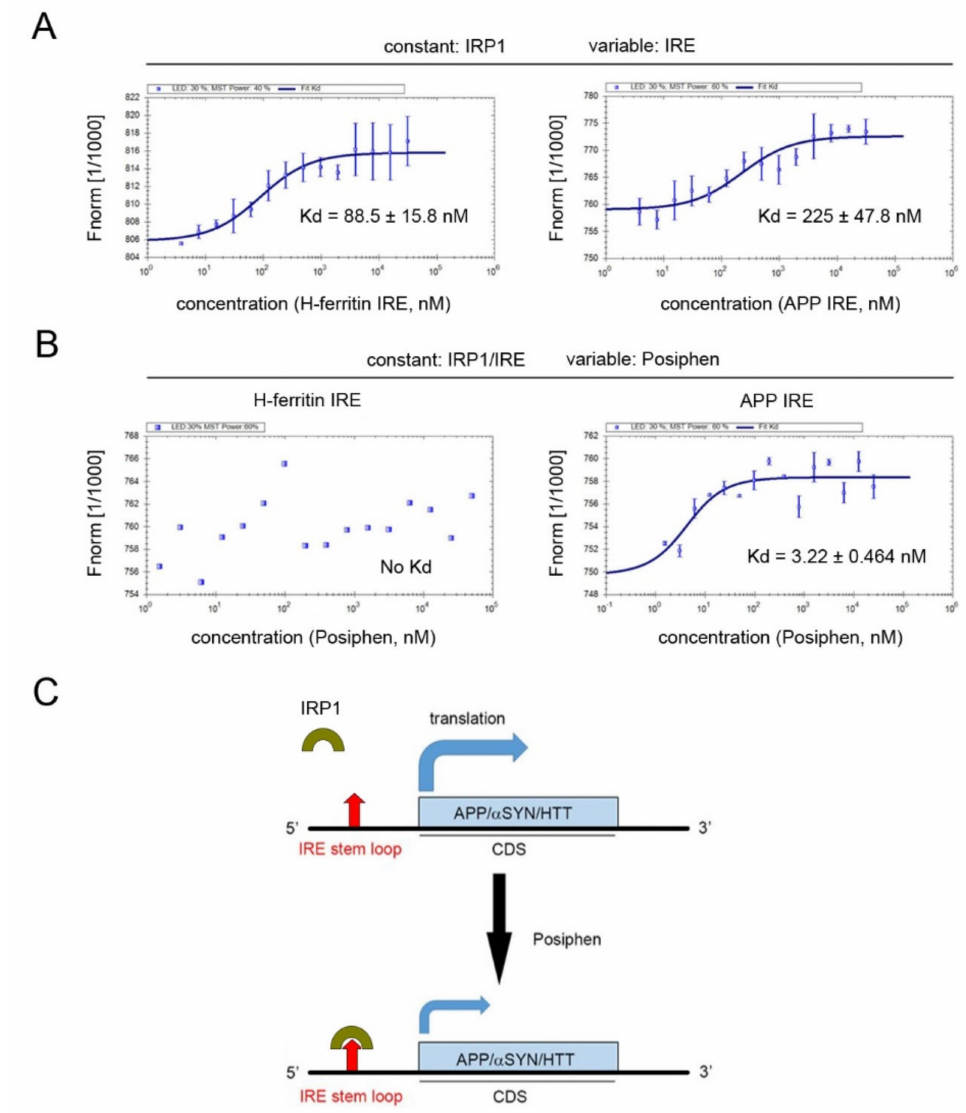
Figure 5. MST equilibrium binding assays of IRP1/RNA and Posiphen. ( A ) IRP1 was incubated with the H-ferritin canonical IRE RNA or the APP atypical IRE RNA sequences. A saturation curve was received using a fixed concentration of labeled IRP1 and increasing concentrations of RNA. IRP1 bound to H-ferritin IRE RNA ( left ) and to APP IRE RNA ( right ). ( B ) At a fixed concentration of IRP1 and IRE RNA of either H-ferritin or APP and increasing Posiphen concentrations, Posiphen only bound to the IRP1/APP IRE complex ( right panel ) but not to IRP1/H-ferritin IRE complex ( left ). ( C ) A working model for Posiphen to repress the translation of mRNA containing an atypical IRE in the 5 (cid:48) -UTR. IRP1 controls the expression of APP, α SYN and HTT whose mRNAs harbor an atypical IRE as well as L-and H-ferritin and ferroportin whose mRNAs contain a canonical IRE in an iron-dependent manner. Posiphen can bind to IRP1/atypical IRE complex, but not IRP1/canonical IRE complex and was predicted to potentiate the binding of IRP1 to IRE, thus further prohibiting 40S ribosome access to the 5 (cid:48) -UTRs of these mRNAs encoding APP, α SYN and HTT and reducing their translation. IRE: iron-responsive element; CDS: coding